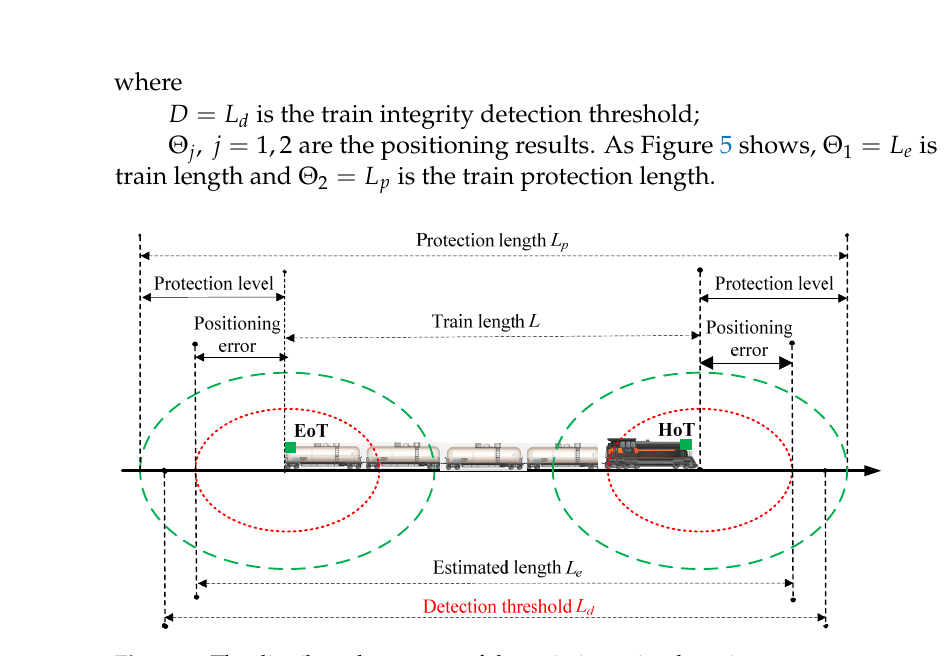
i Figure 4. The probabilistic analysis method.